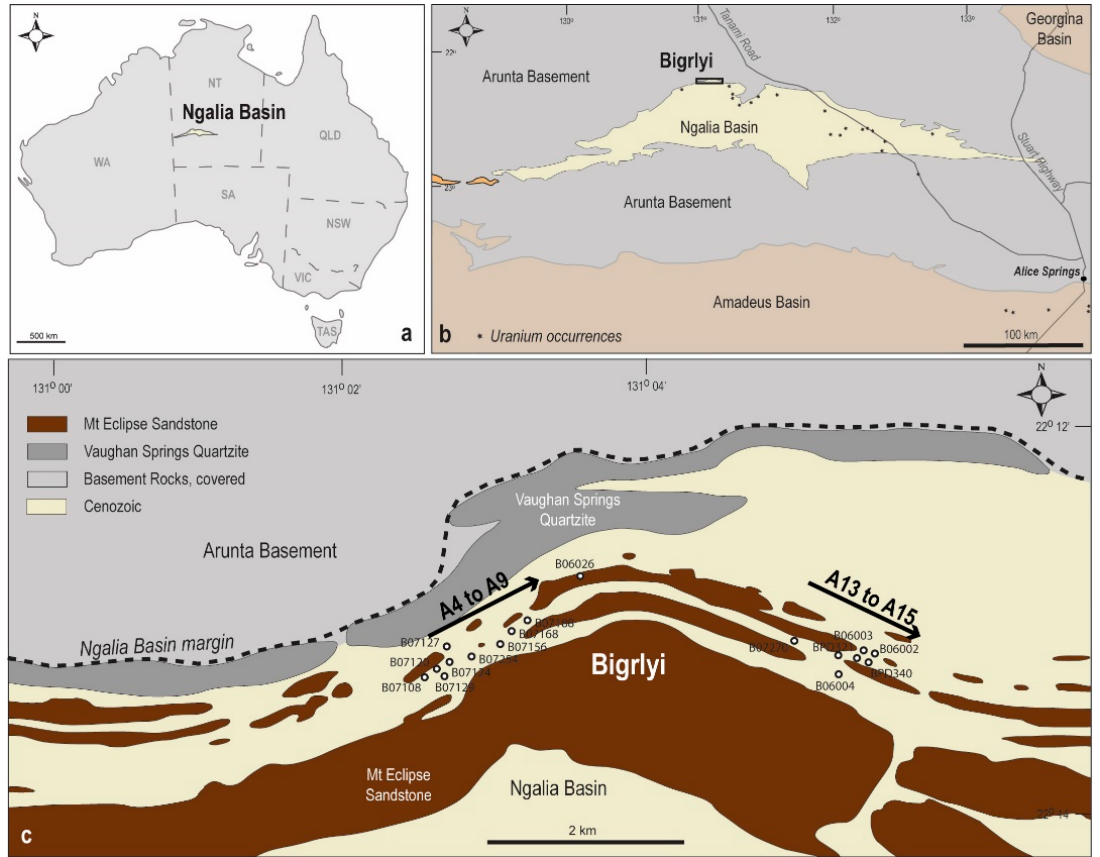
Figure 1. Ngalia Basin and Bigrlyi deposit location maps. ( a ) Ngalia Basin location in central Australia, ( b ) Bigrlyi deposit in relation to other uranium occurrences in the region, ( c ) map showing the location of the A4 to A9 and the A13 to A15 sub-deposit corridors, with drill cores studied.